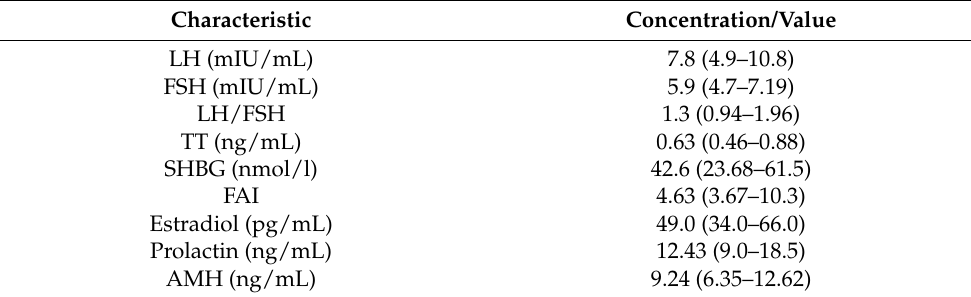
Table 2. Hormonal profile at the beginning of the follow-up ( n = 31).